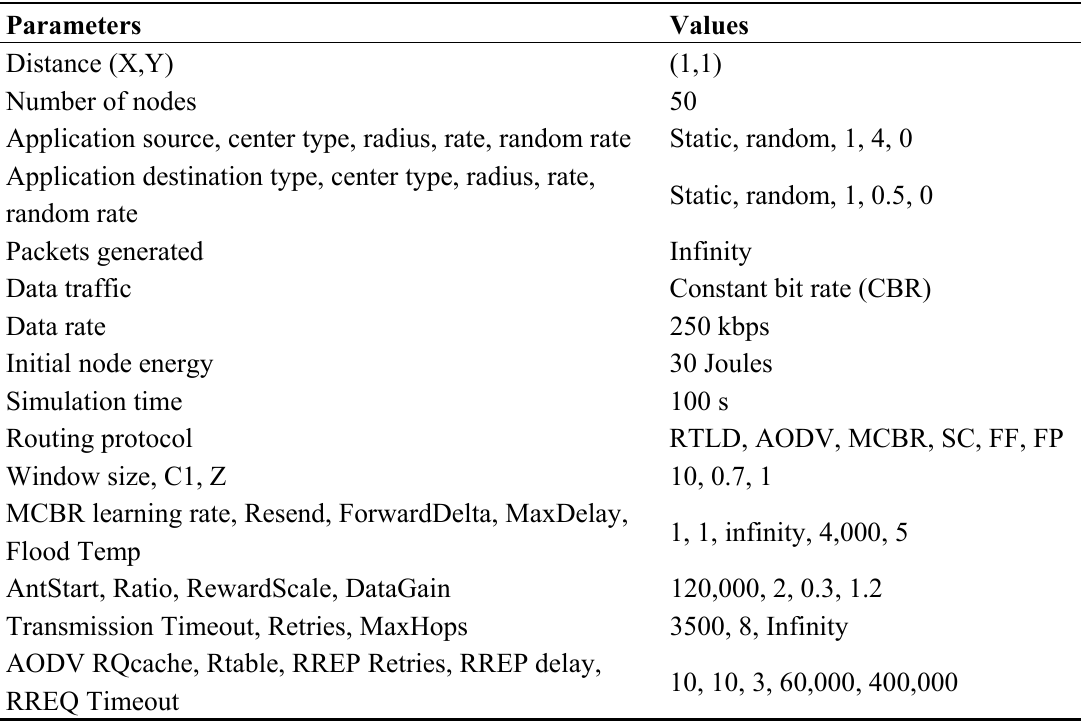
Table 1. Simulation